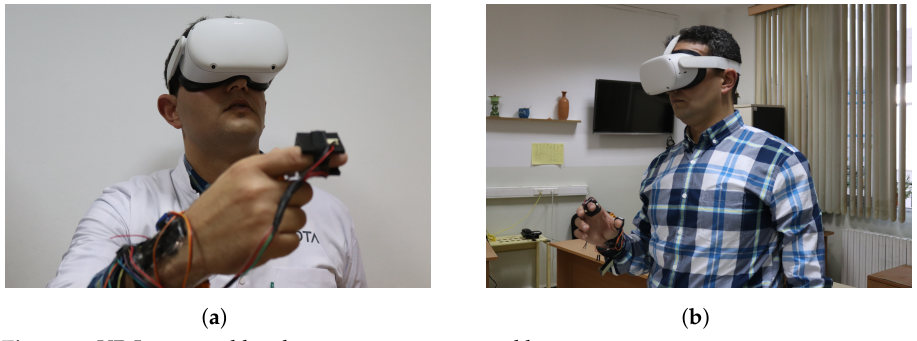
Figure 5. VR Integrated hardware prototype weared by a user.